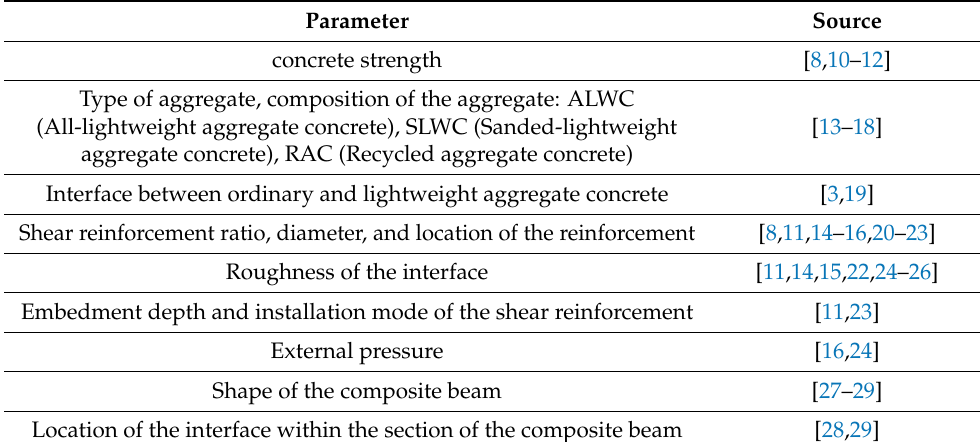
Table 1. Parameters considered in the previous experimental investigations.